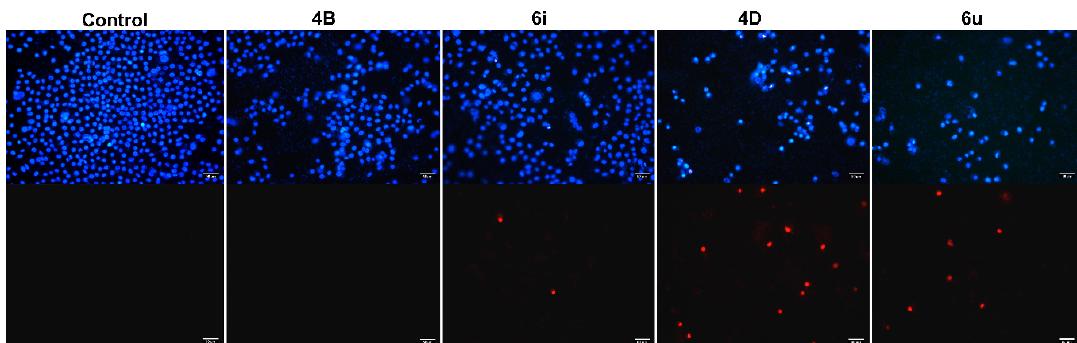
Figure 1. Morphological observation was performed by Hoechst 33342/propidium iodide (PI) dual staining. A549 cells were treated with 4B , 6i , 4D , and 6u at 8 μ M for 48 h, and then stained with Hoechst 33342 and PI at 37 °C in dark conditions. The stained cells were observed under a fluorescence microscope (Leica DM6B, Leica, Nussloch, Germany). Hoechst 33342 was used to stain the living and apoptotic nuclei, and emitted blue fluorescence ( upper ). PI was used to stain the dead nuclei and emitted red fluorescence ( lower ).